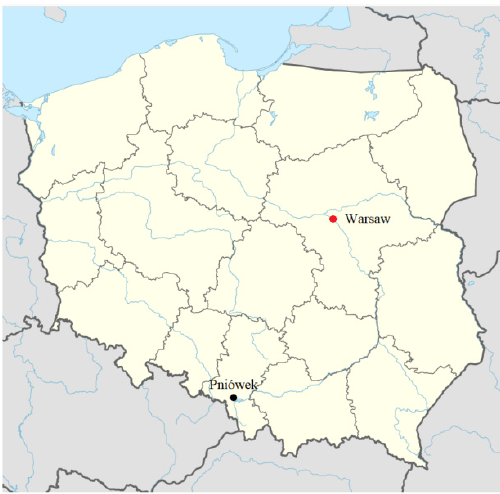
Figure 5. Location of the Pniówek coal mine.